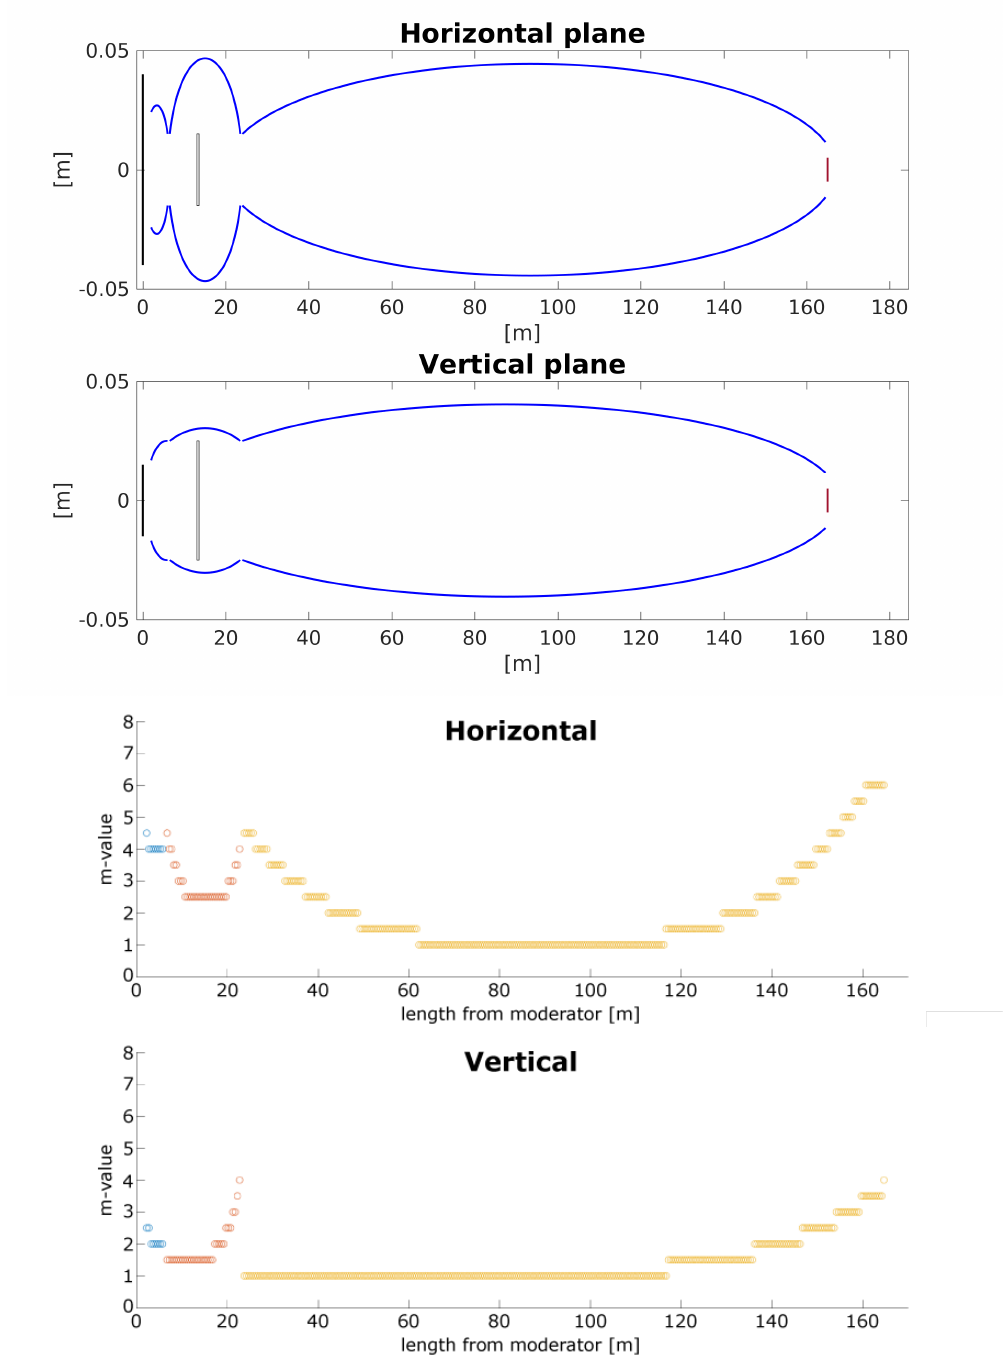
Figure A4. Beamstop guide. Guide dimensions and coating values. Top panels: Schematic drawing of the extended beamstop guide, optimized for the wavelength band 1.5–4.0 Å. The figures are not to scale. Bottom panels: The optimized m-distribution in the horizontal and vertical directions,